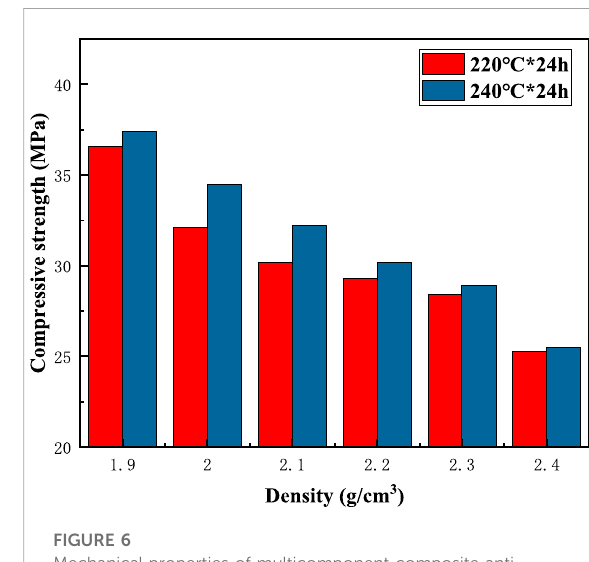
Mechanical properties of multicomponent composite anti- corrosion cement slurry system under different